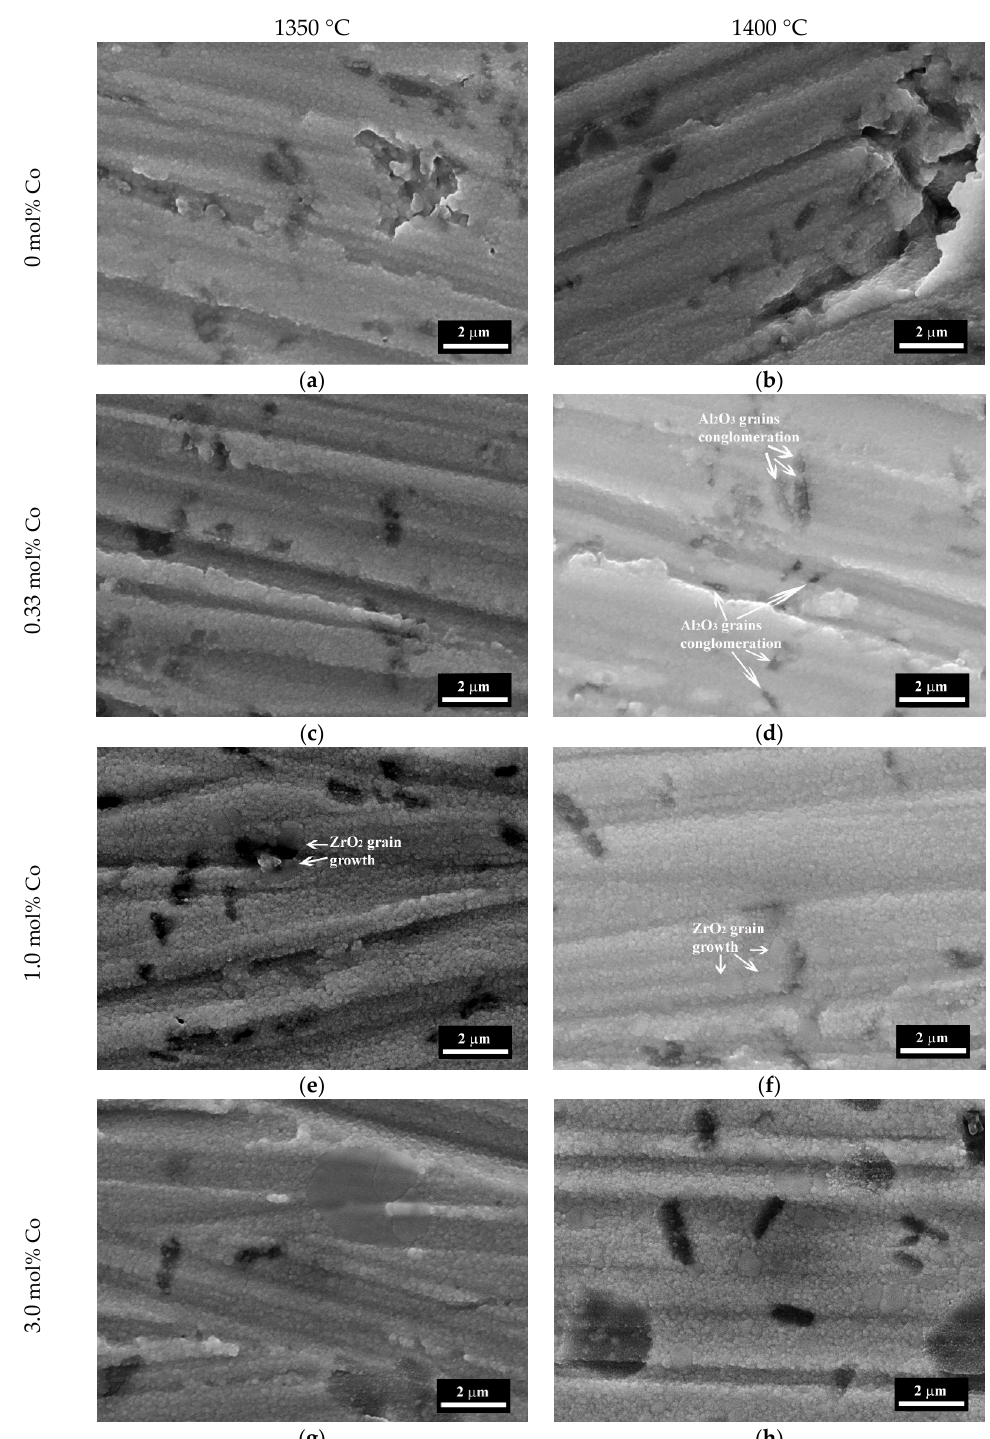
Figure 7. SEM images (SE mode) of 3Y-TZP-Al 2 O 3 ceramics: composition I ( a , b ), composition II ( c , d ), composition III ( e , f ), composition IV ( g , h ) sintered at 1350 ( a , c , e , g ) and 1400 °C ( b , d , f , h ). Dark colors indicate alumina-rich areas; bright colors indicate zirconia-rich areas.